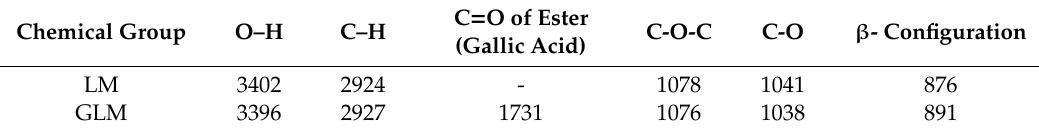
Table 2. Infrared spectra of LM and LMG (positions of the peaks*).